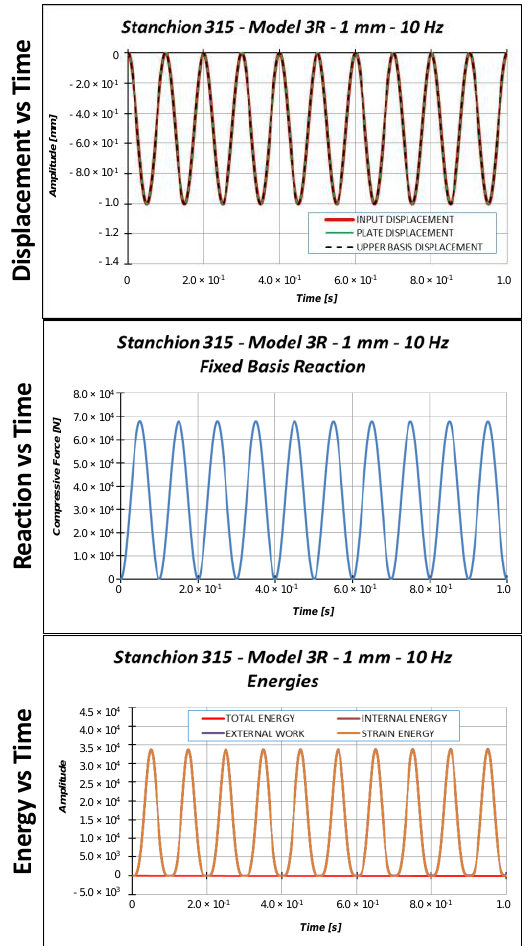
Figure 14. Displacement, reaction, and energies as a function of time: 1.0 mm applied displacement.